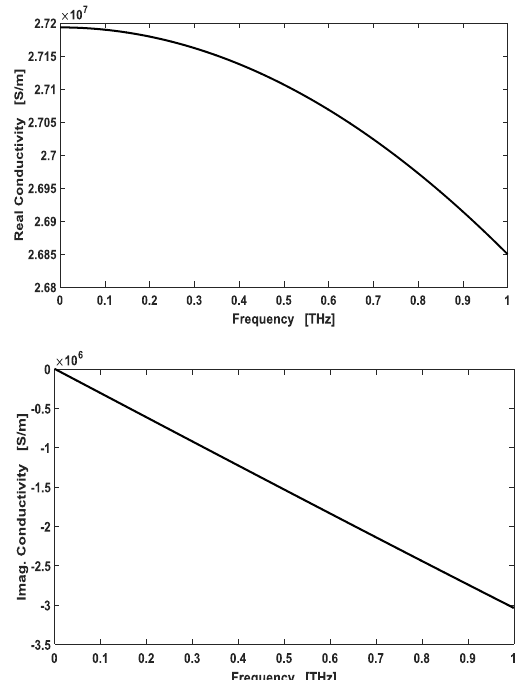
Figure 2: The variation of the complex conductivity (real part and imaginary part) as a function of the frequency for a thin gold film on a silicon